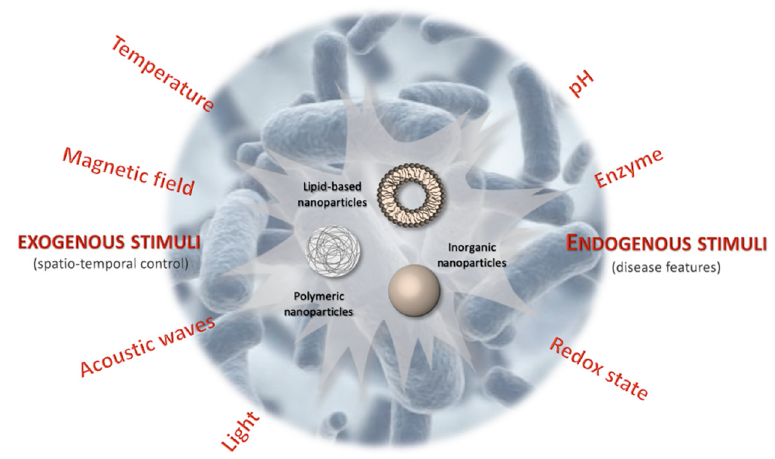
Figure 1. Schematic illustration of stimuli-responsive antibiotic drug-delivery systems. Lipid-based, polymeric and inorganic nanoparticles are the most studied stimuli-responsive drug delivery systems for antibiotic drugs.